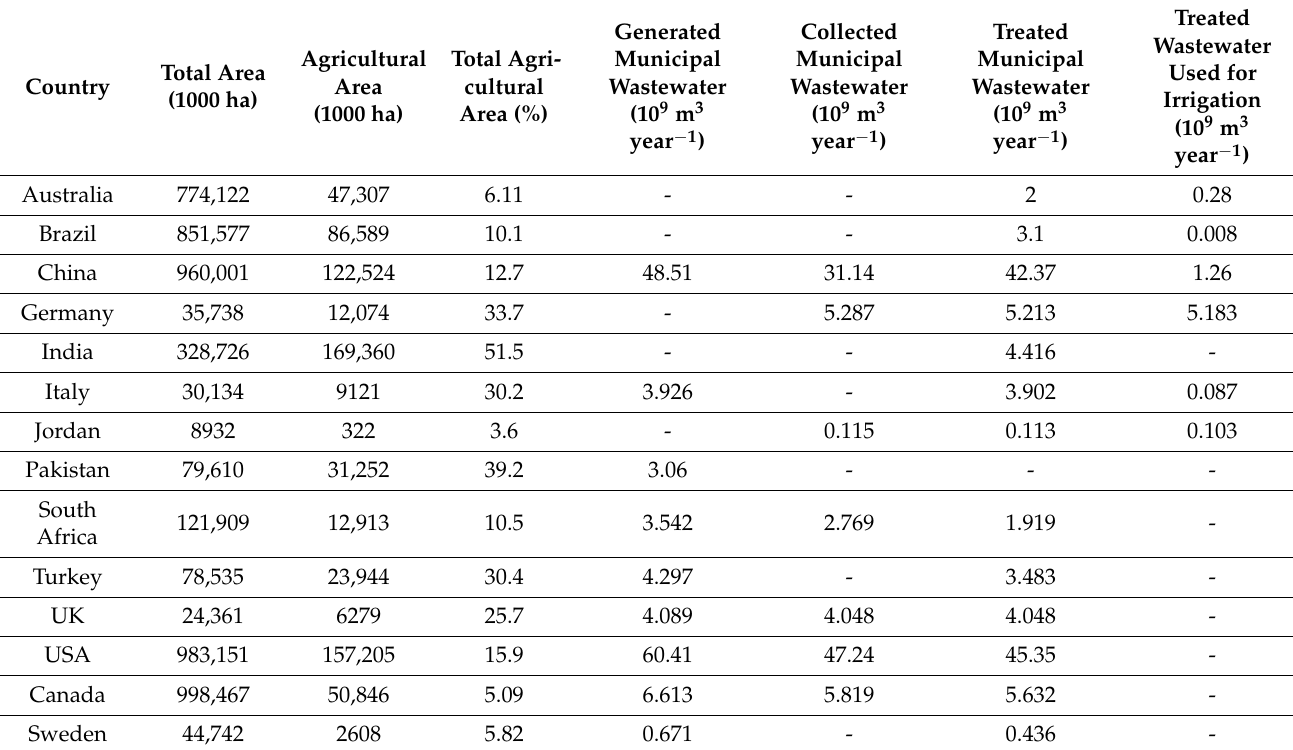
Table 3. The wastewater generation, collection, treatment, and reuse for irrigation of crops in some countries in relation to the total cultivated area